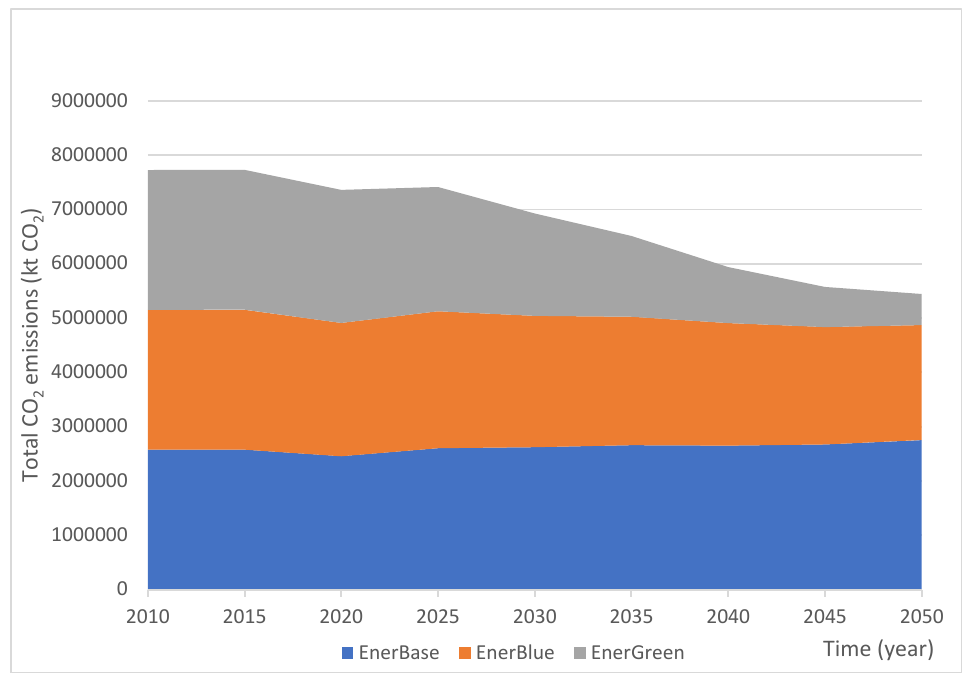
Figure 4. Total CO 2 emissions (incl. industrial processes) in the CIS, kt CO 2 . Source: based on data from [30].